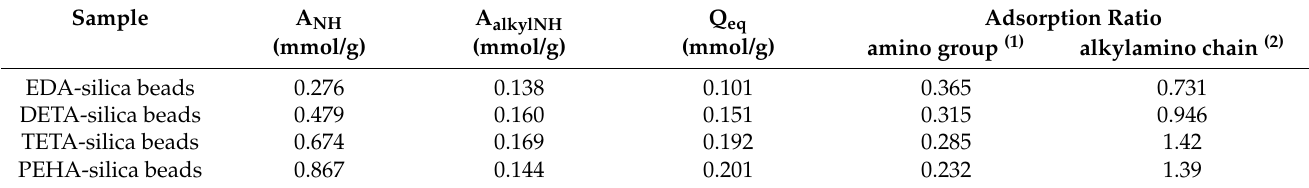
Table 7. The Cr(VI) ion adsorption on silica beads functionalized with GOPTES and subsequently